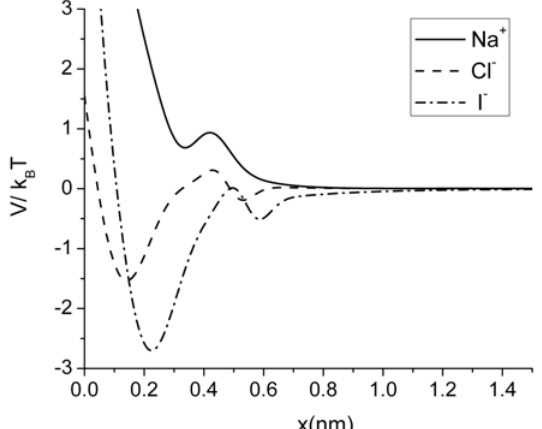
Fig. 8 – Potential of mean force for different ions near the SAM-water interface from molecular simulation (Horinek and Netz 2007).